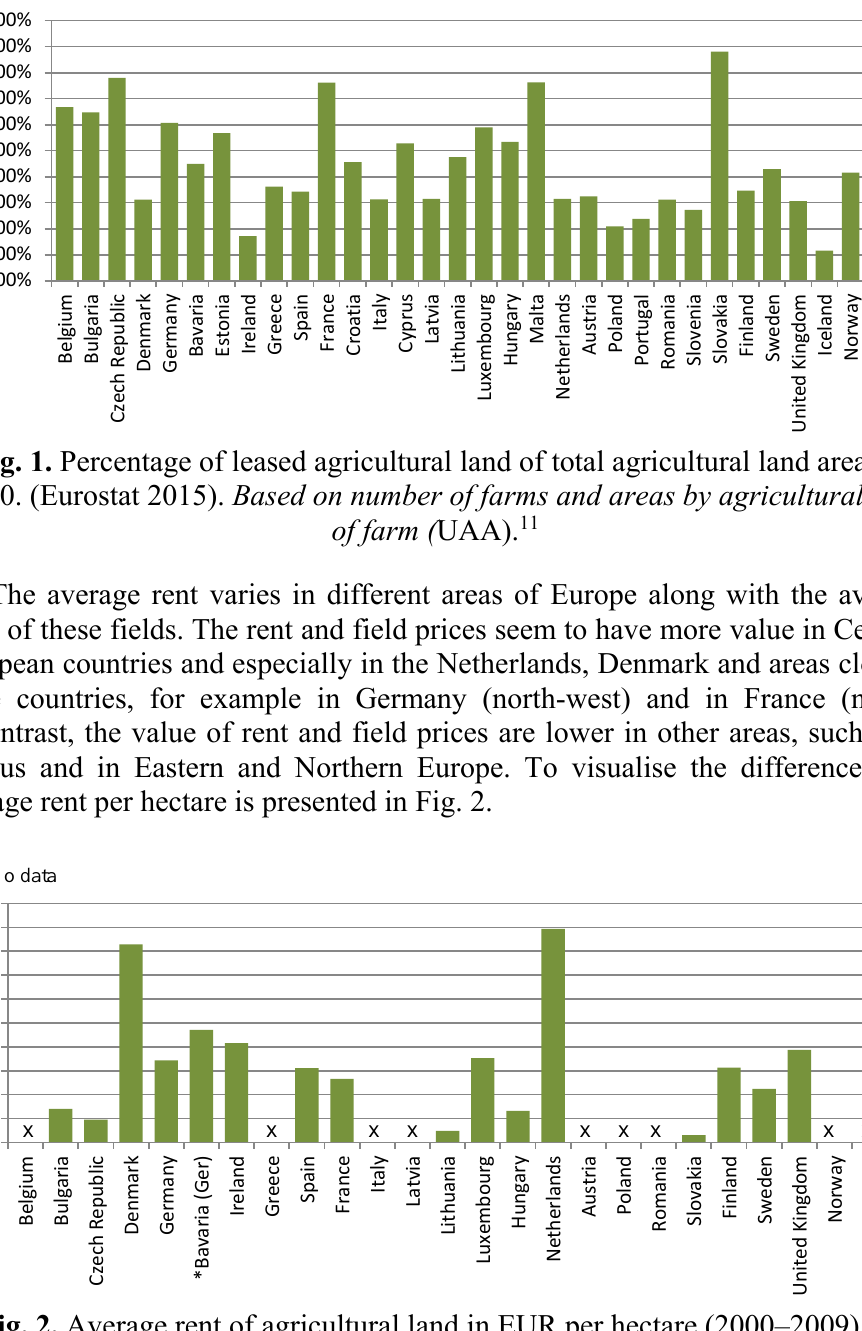
Fig. 2. Average rent of agricultural land in EUR per hectare (2000–2009) of displayed countries and Bavaria 2001–2010. (Eurostat, 2015; Agrarbericht,